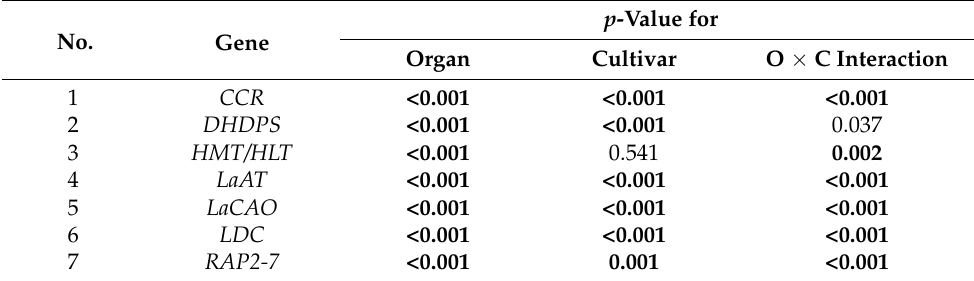
Table 3. Summary of ANOVA analysis for testing the effect of plant organ, cultivar, and their interaction on the expression of alkaloid genes (qPCR) in two narrow-leafed lupin cultivars—Oskar (high-alkaloid, bitter) and Regent (low-alkaloid, sweet). Effects were considered significant for p < 0.01 (marked in bold). Full names of genes are listed in Table